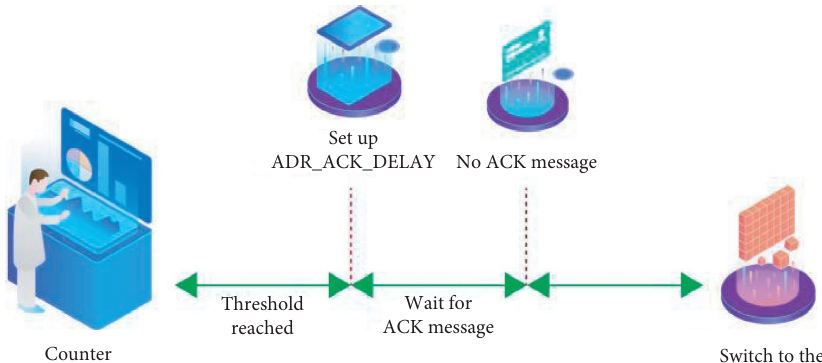
Figure 1: Schematic diagram of LoRaWAN adaptive data rate.